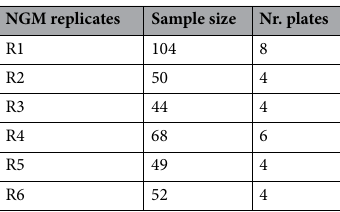
NGM replicates Sample size Nr.